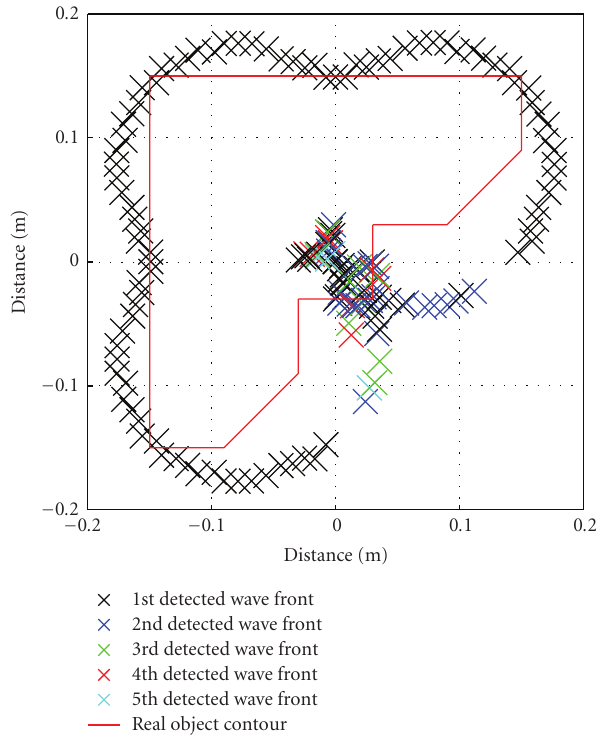
Figure 7: Polar diagrams of estimated versus real object cross- section.